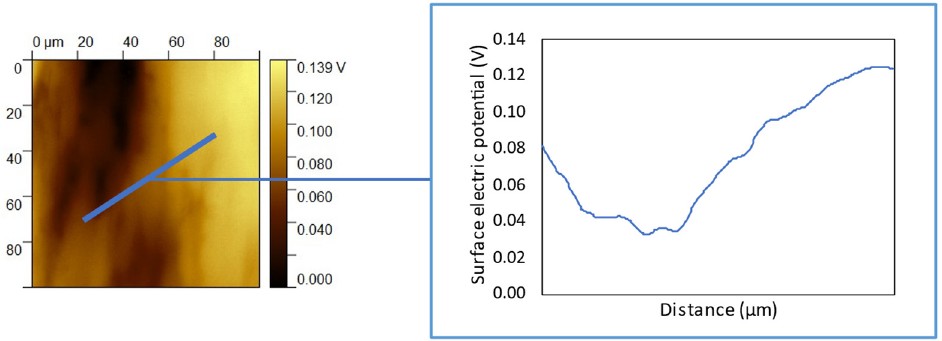
Figure 4. KPFM surface potential as a function of the distance across the interface between a bare (light area) and nisin-functionalized (darker area) region (functionalization at pH 6).